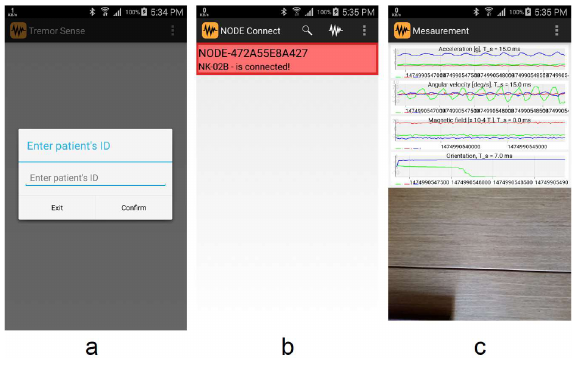
Figure 3. TremorSense Android mobile